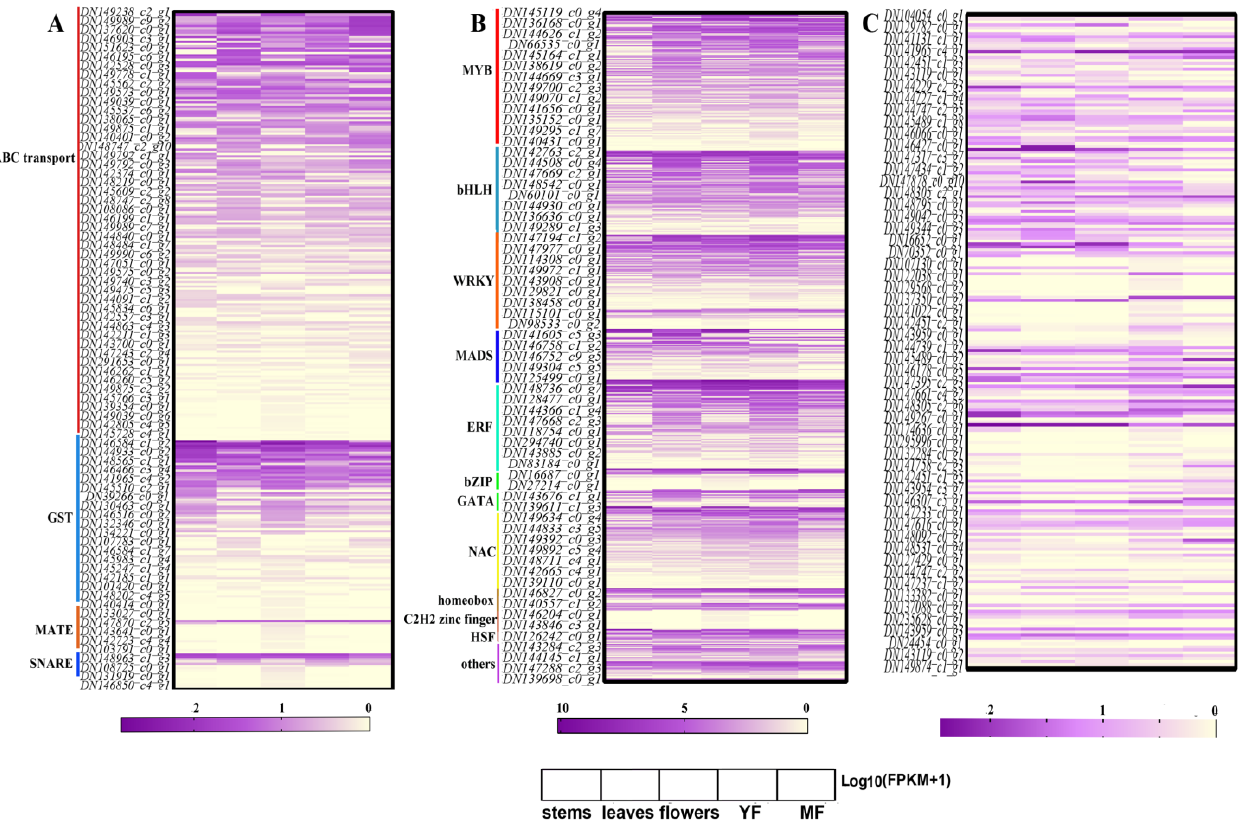
Figure 4. Heatmap diagrams of the expression levels among five tissues. The DEGs are related to ( A ) transporters, ( B ) transcription factors, and ( C ) P450 in five organs. YF, young fruits; MF, mature fruits.